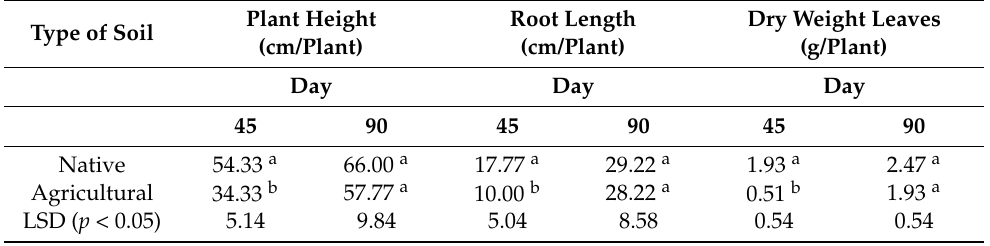
Table 3. Effect of two soil types on growth parameters of Moringa oleifera